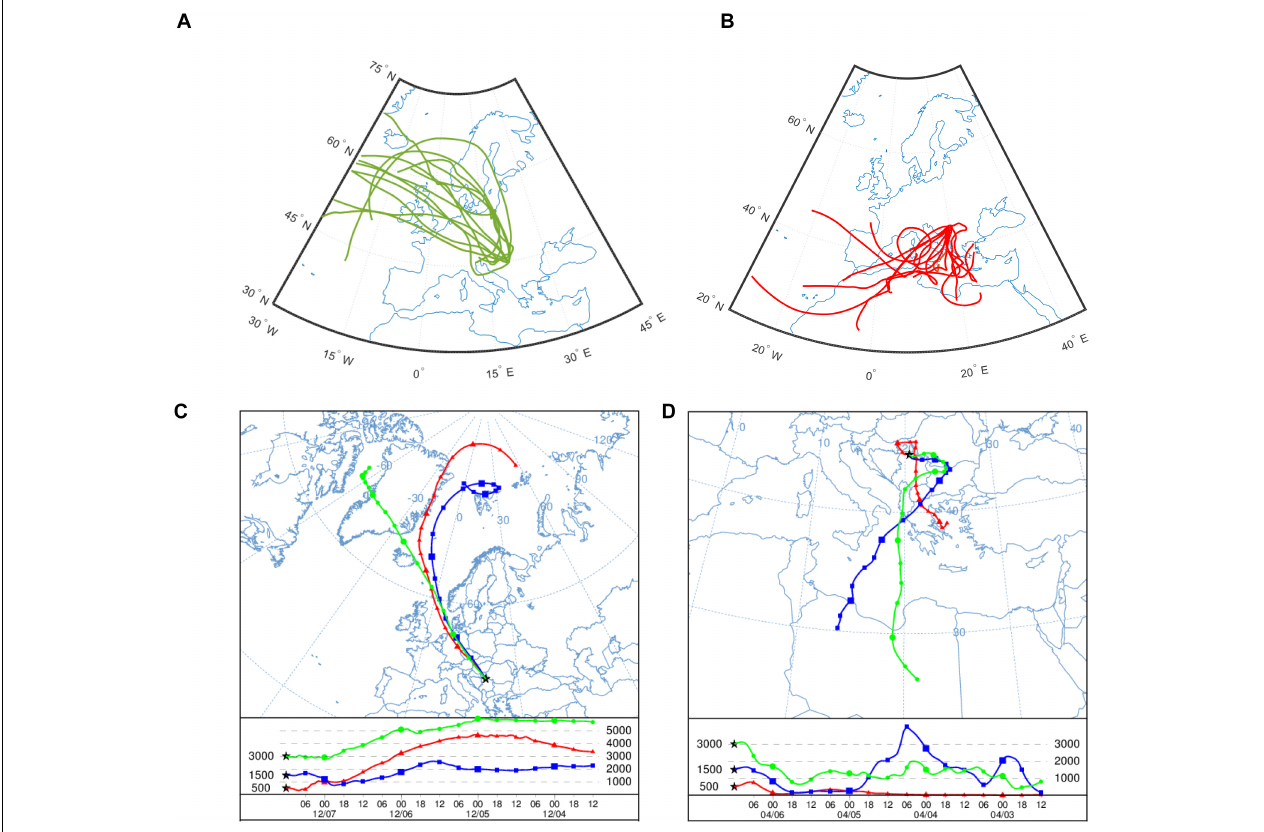
FIGURE 2 | Backward air trajectories approaching Belgrade for the arrival height of 3000 m from: (A) Iceland (17 cases) and (B) Sahara (18 cases) during the period 2012–2013. Selected 4 days backward trajectories ending in Belgrade at 500, 1500, and 3000 m on: (C) December 7, 2013 and (D) April 6,